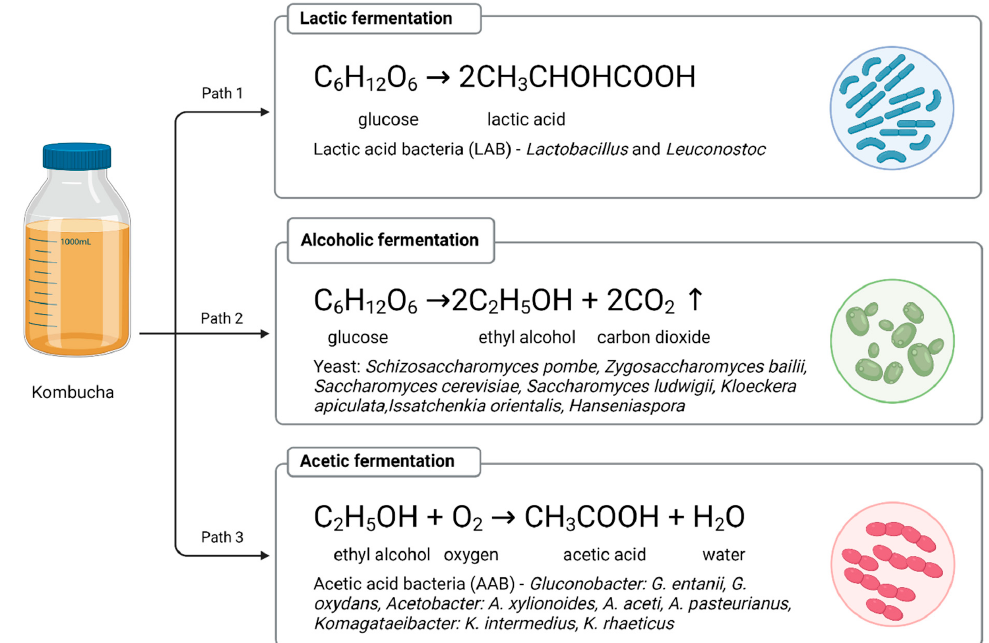
Figure 1. Types of fermentation in Kombucha. Created with BioRender.com.